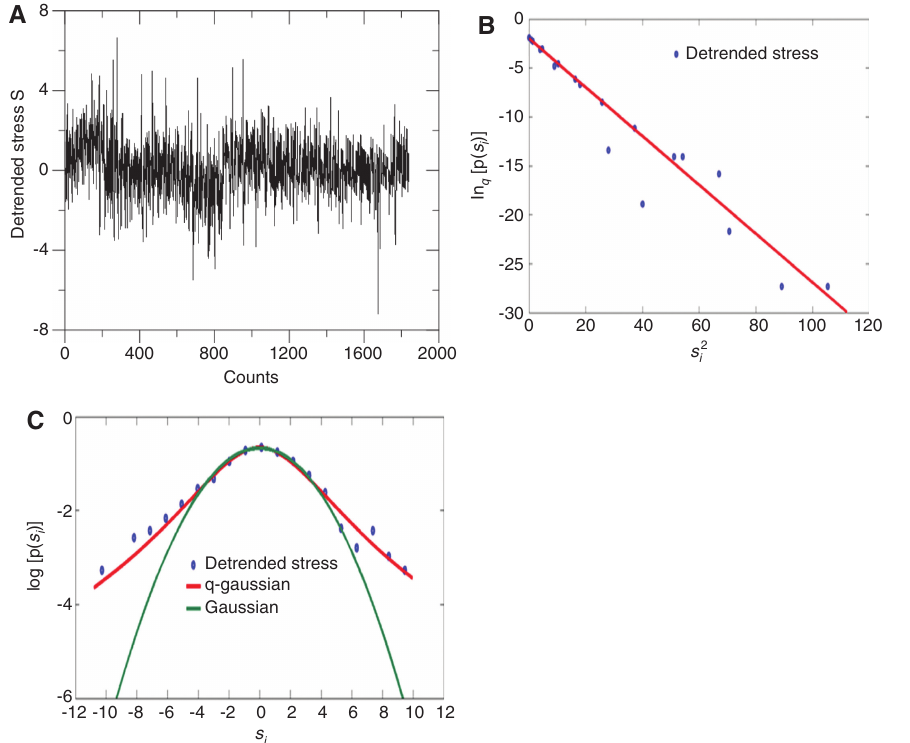
[ p ( s )] and ( s ) 2 for the q i i